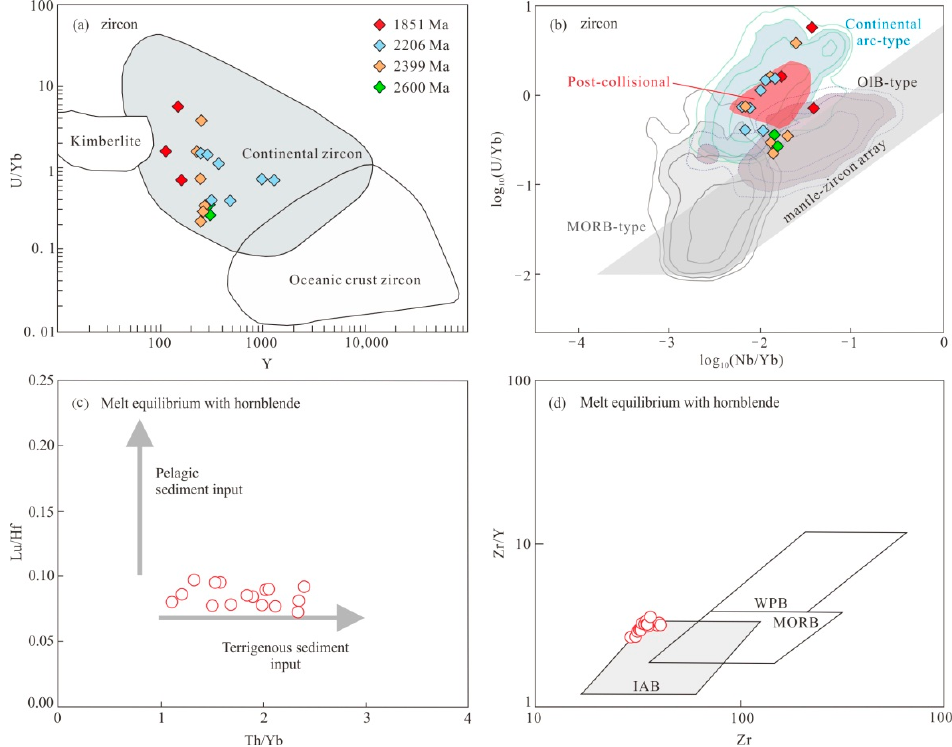
Figure 8. U/Yb vs. Y [39] ( a ), U/Yb vs. Nb/Yb [40] ( b ) for zircons, Lu/Hf vs. Th/Yb [53] ( c ), and Zr/Y vs. Zr [62] ( d ) for equilibrium melt of hornblendes from the Paleoproterozoic Gaositai hornblendite.